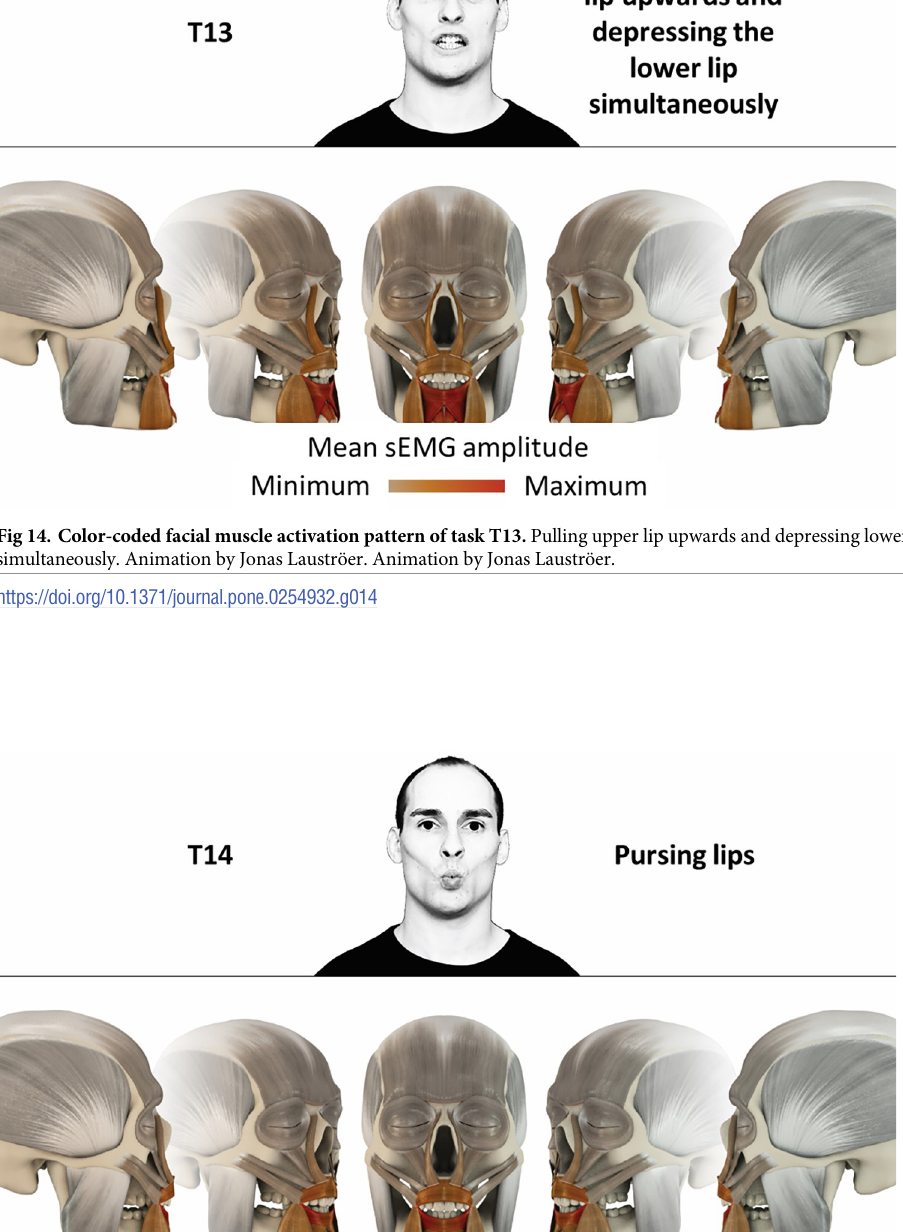
PLOS ONE | https://doi.org/10.1371/journal.pone.0254932 July 19,